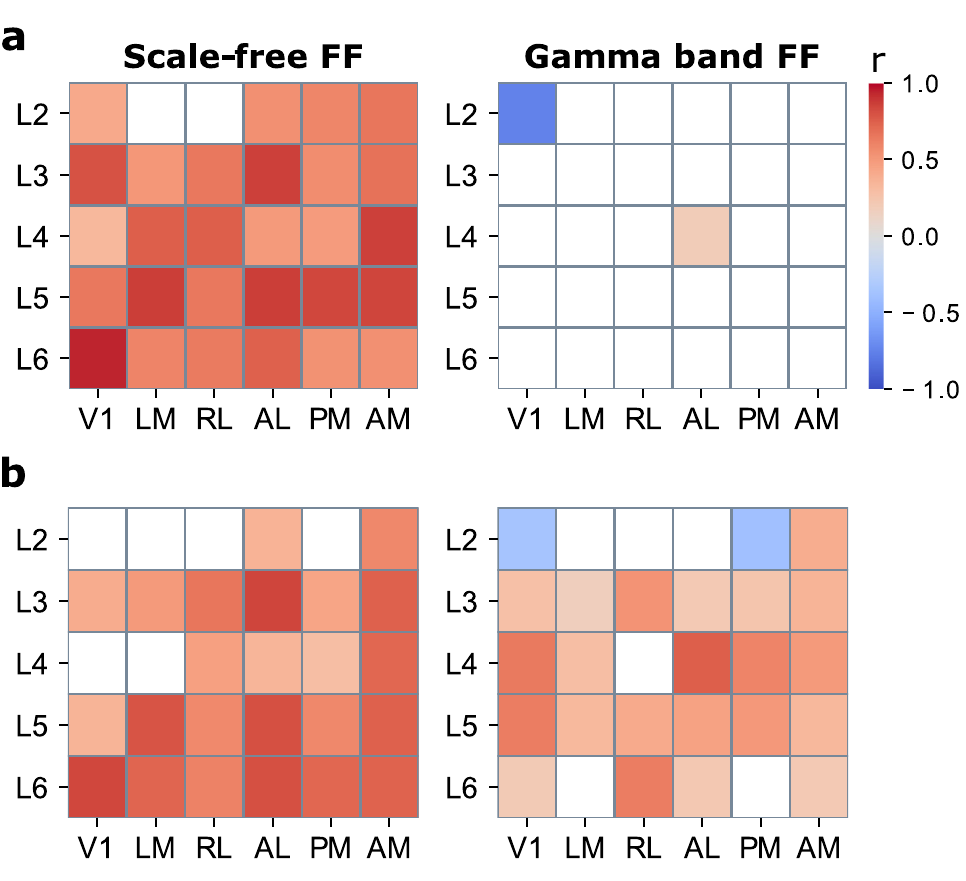
Fig 6. Correlations between network amplitudes and spiking activity. (a) Correlation coefficients ( r ) per area and layer for high contrast stimuli and (b) for low contrast stimuli. Colored areas indicate statistically significant correlations at p < 0.05, 2-tailed bootstrapped distribution. L1 was excluded for lack of spiking activity. Underlying data: https://osf.io/pqf7z. FF, feedforward.